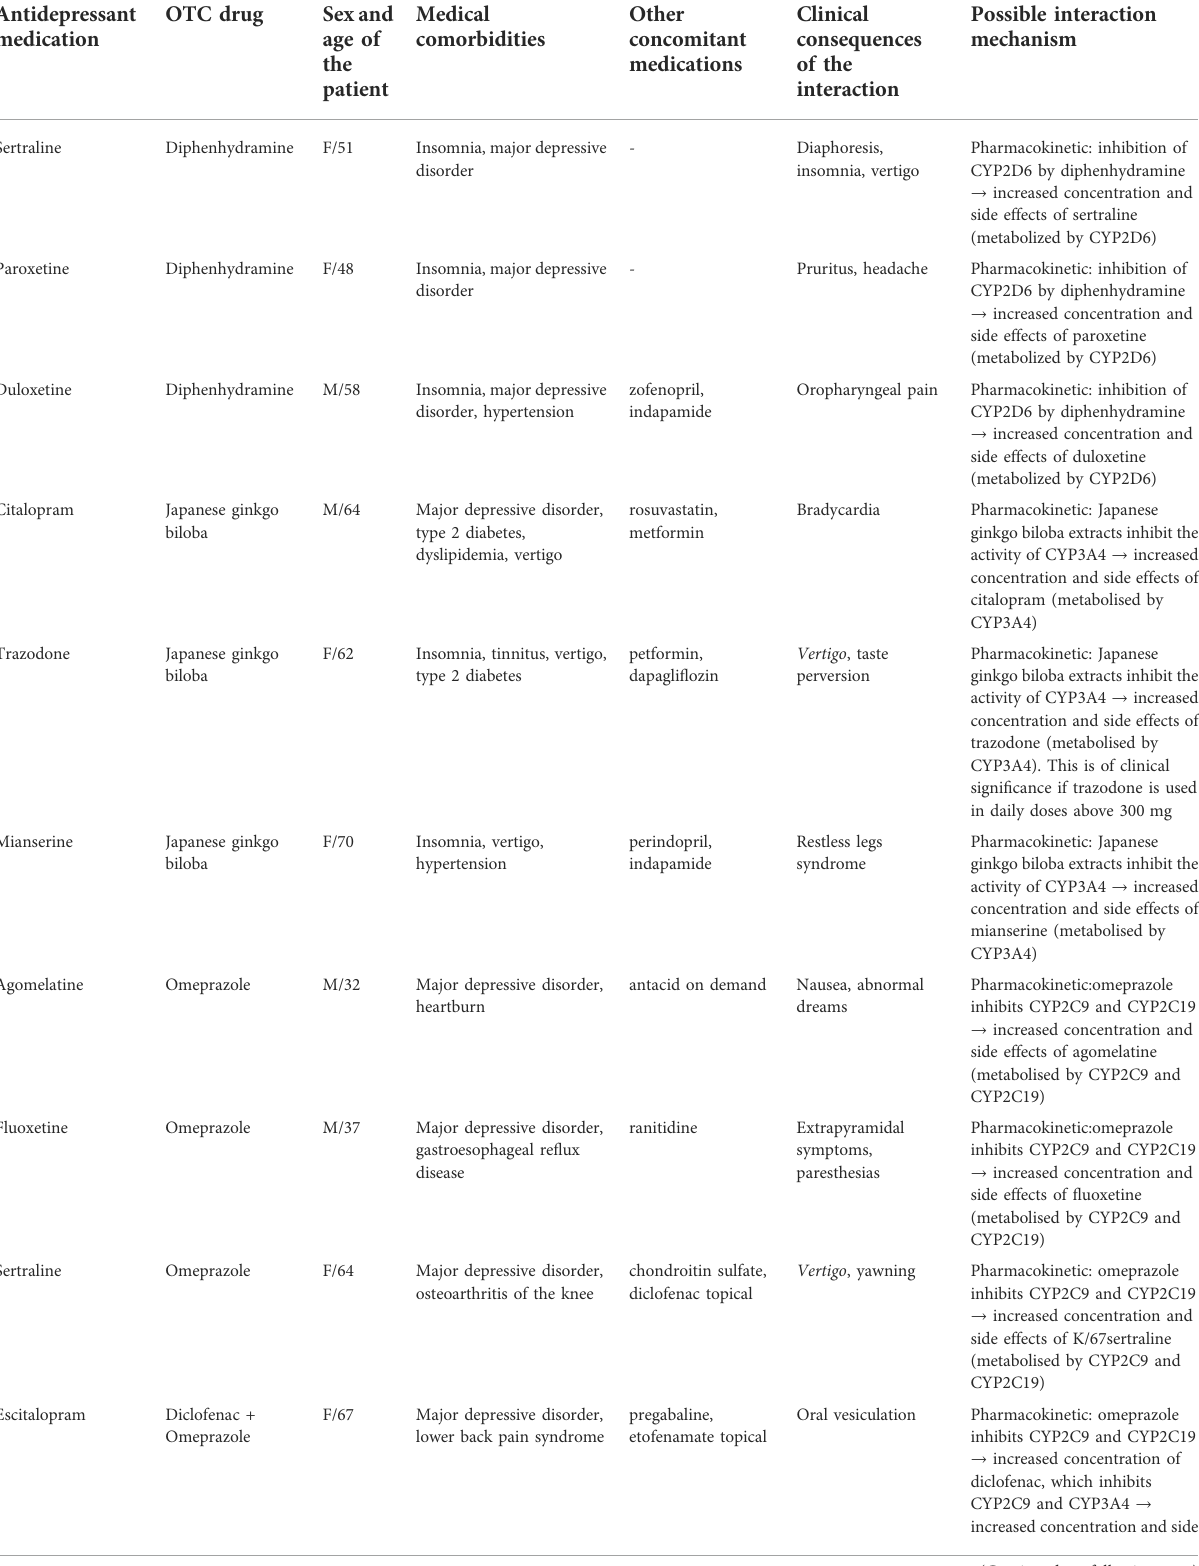
TABLE 1 Interactions between antidepressants and over-the-counter drugs in the analyzed group and possible interaction